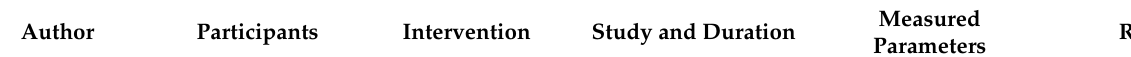
Table 2. Studies carried out with both non-alcoholic beer and conventional